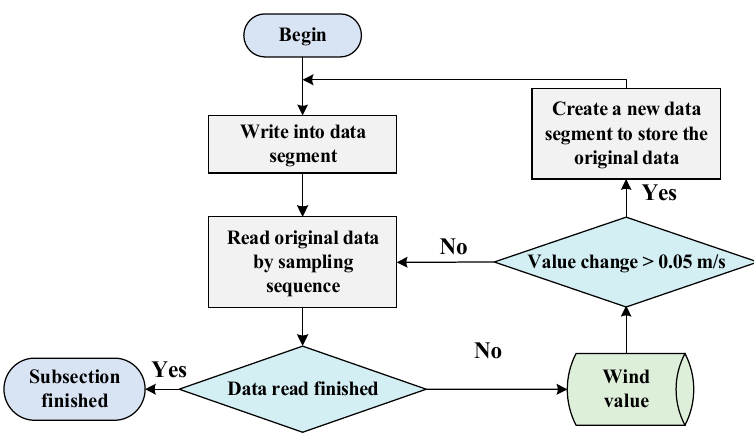
Figure 6. Flowchart of data division by wind speed.